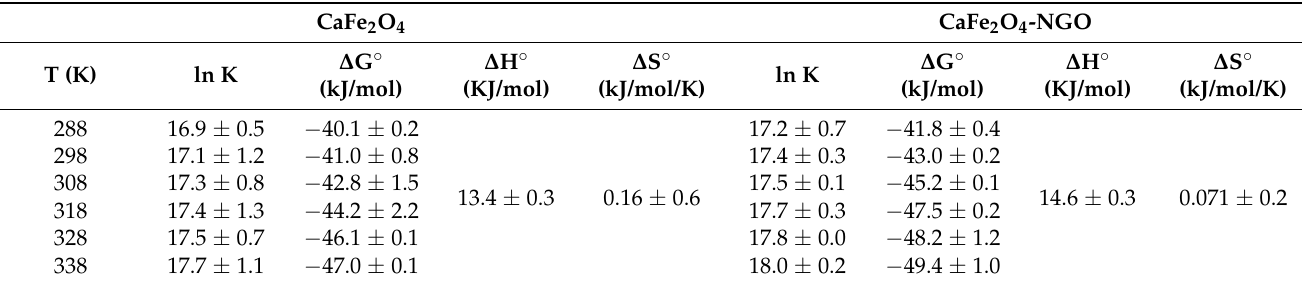
Table 4. Thermodynamic parameters for adsorption of Pb(II)